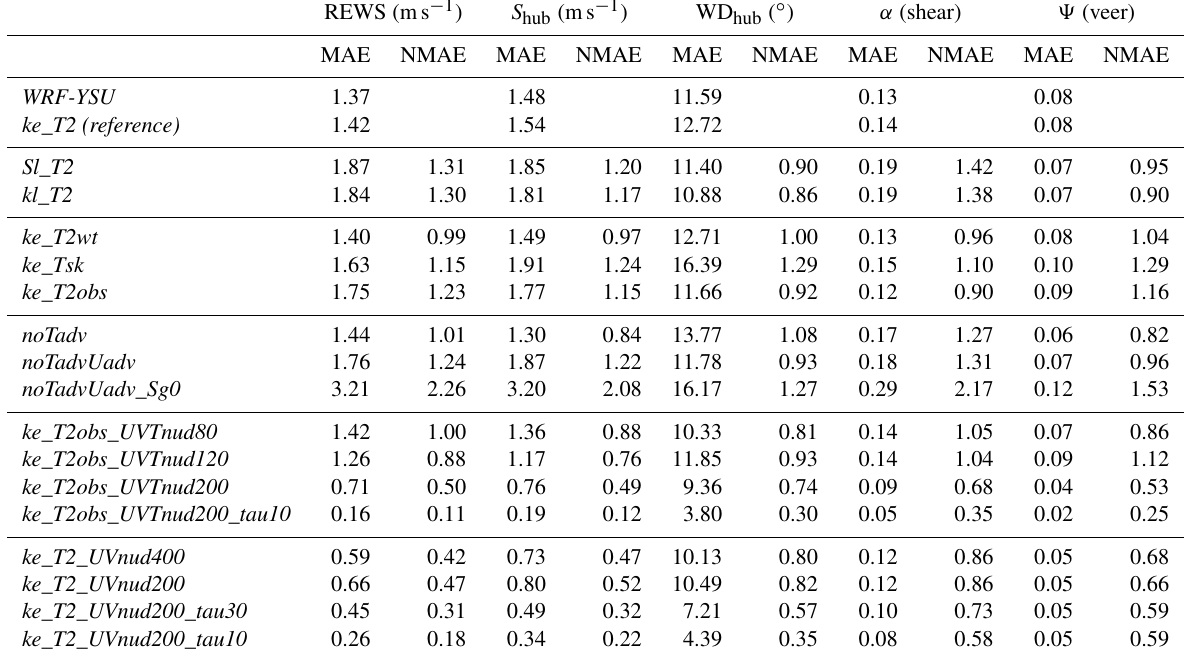
Table 2. MAE and normalized MAE with respect to the reference k - ε SCM